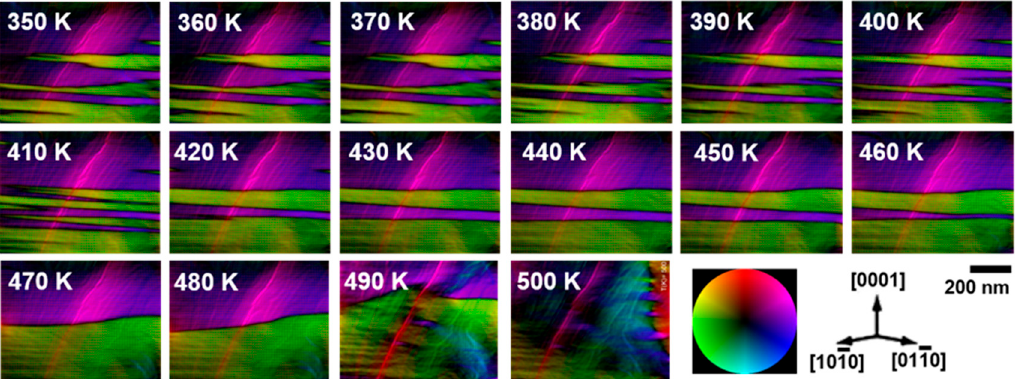
Figure 4. Sequential images of the magnetic vector maps of the Z-type hexagonal ferrite by heating from 350 to 500 K. The color wheel represents the magnetization direction at every point.